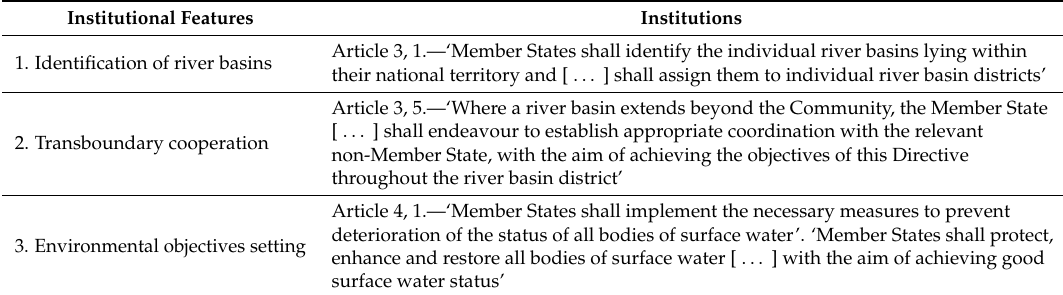
Table 1. Institutional features and institutions of the Water Framework Directive (WFD)